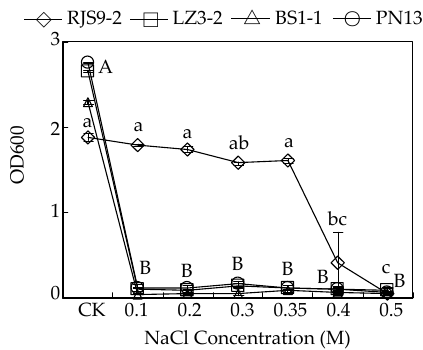
Figure 1. Effects of different NaCl levels on the growth of rhizobia. The four tested Bradyrhizobium strains were separately inoculated onto liquid YMA medium containing 0.0017 (CK), 0.1, 0.2, 0.3, 0.35, 0.4, or 0.5 M NaCl and further incubated at 28 °C and 180 rpm. The optical density (OD) of the cultures was recorded at 600 nm after 8 days of NaCl treatment. Each bar represents the mean of four biological replicates with standard error. An individual flask was considered one biological replicate. The same lowercase letter indicates no significant difference at p < 0.05 (Duncan’s test) in RJS9-2 among different treatments. The same uppercase letter indicates no significant difference at p < 0.05 (Duncan’s test) in LZ3-2, BS1-1, and PN13-3 among different treatments, respectively. Due to the same results from Duncan’s test of LZ3-2, BS1-1, and PN13-3, only one group of representative uppercase letters is showed in the figure.